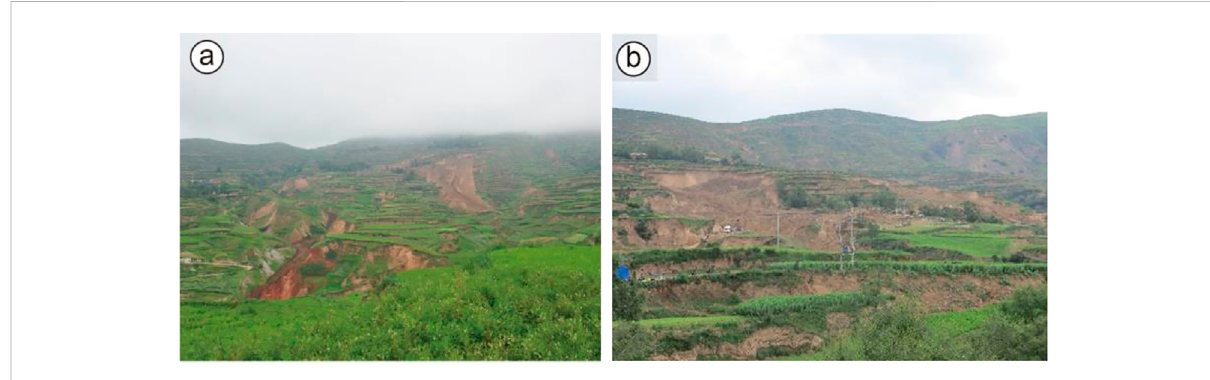
FIGURE 2 Prototype slope. (A) Distant view of the landslide in Yongguang Village; (B) close-range view of the landslide in Yongguang